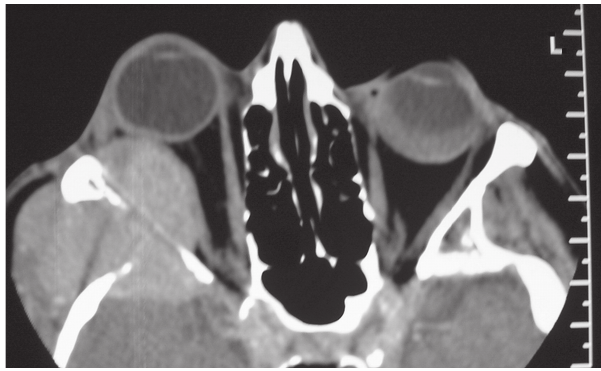
Figure 1. Computed tomography at the level of the eyes shows an orbital soft tissue mass leading to bone erosion and intracranial invasion.